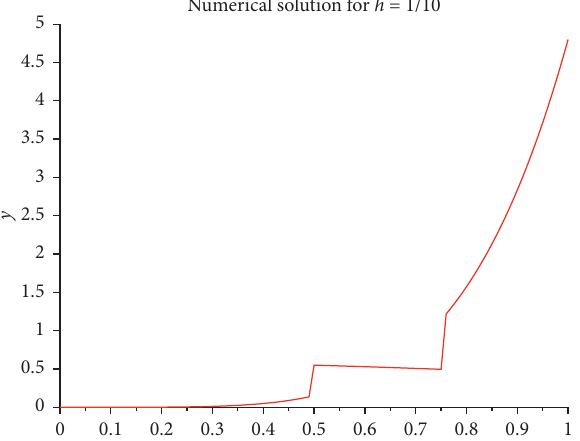
Figure 1: Numerical solution ρ ( 1/10 )